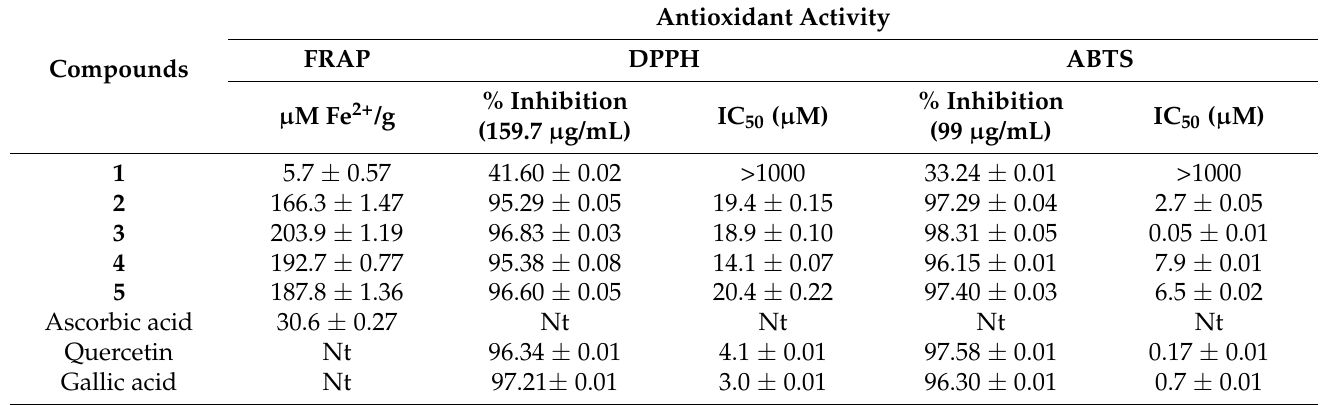
Table 3. Antioxidant activity of compounds 1 – 5 .